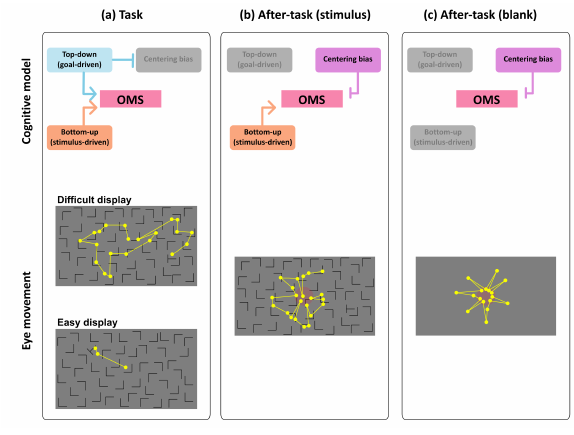
Figure-08. Cognitive model of OMS and eye movement patterns in all phases. Each after-task phase was conducted following task phase. Yellow dots represent fixation points, yellow lines repre- sent saccades, and red circles represent center of display. These fixation points and saccades paths are